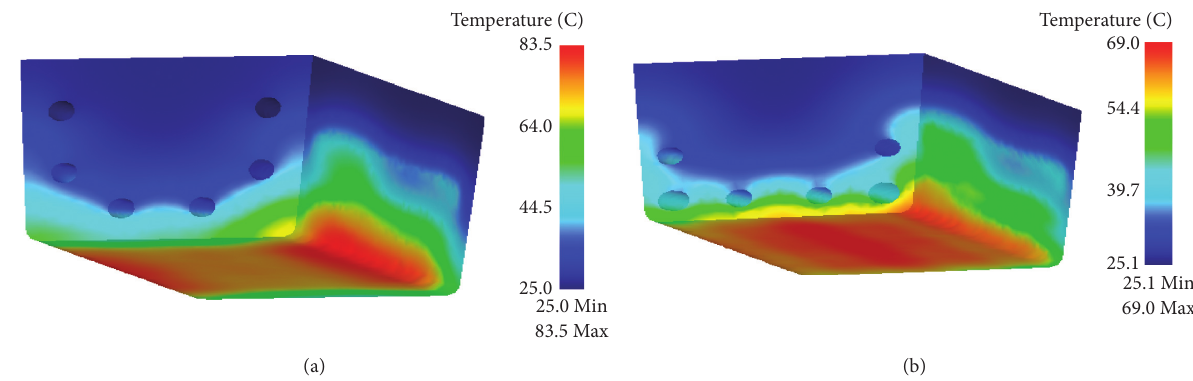
Figure 6: Parameter optimization of the cooling channels in punch.